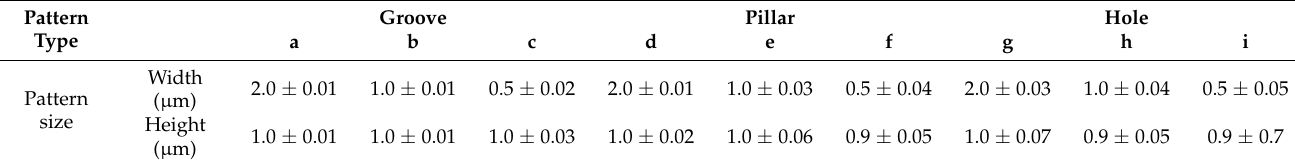
Figure 3. Laser microscope images of the patterned PLGA membranes. Groove widths of ( a ) 2.0, ( b ) 1.0, and ( c ) 0.5 µ m; pillar widths of ( d ) 2.0, ( e ) 1.0, and ( f ) 0.5 µ m; and hole widths of ( g ) 2.0, ( h ) 1.0, and ( i ) 0.5 µ m. Scale bar = 2.0 µ m.